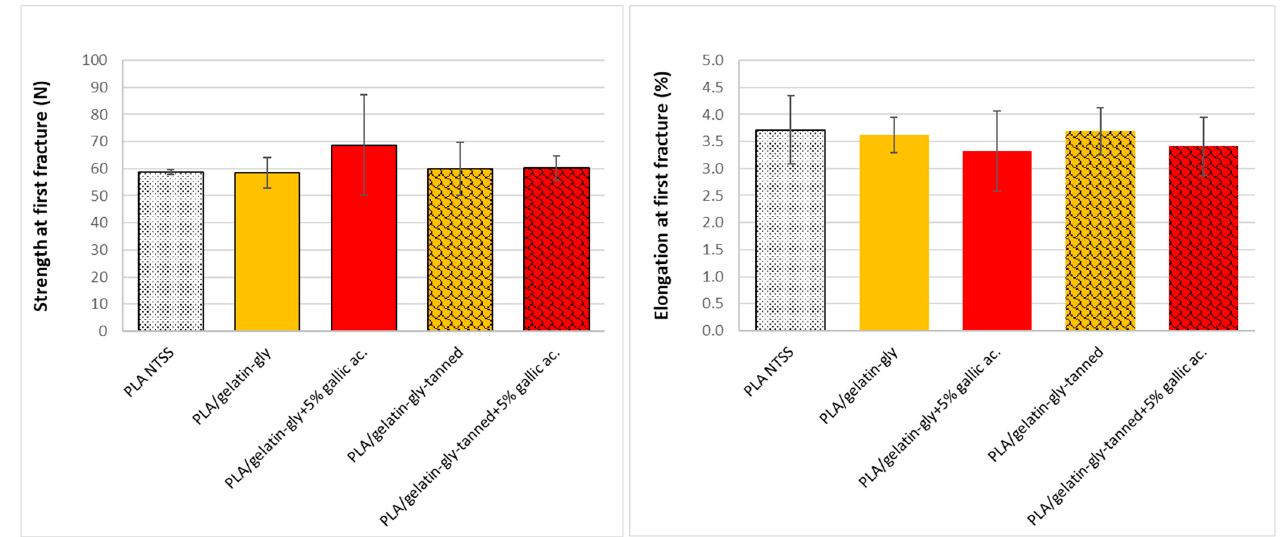
Figure 6. Influence of the coating composition on the first fracture (delamination), at 25 °C and 50% RH.